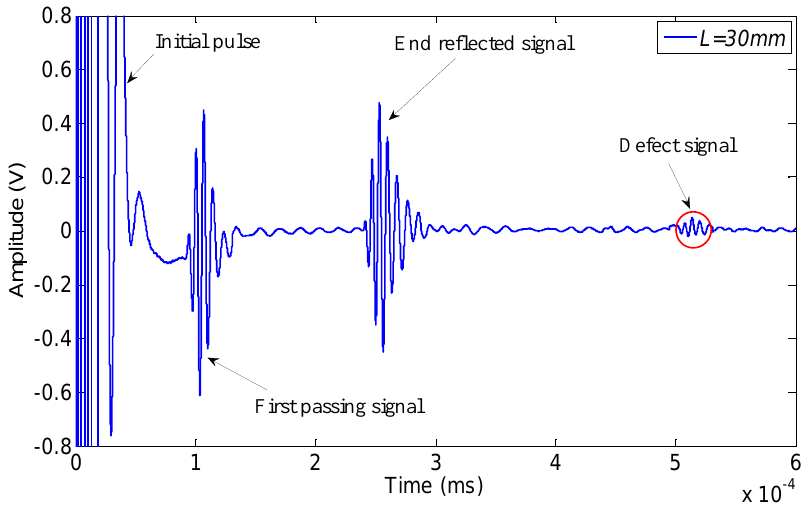
) of the first end reflected signals under four pp